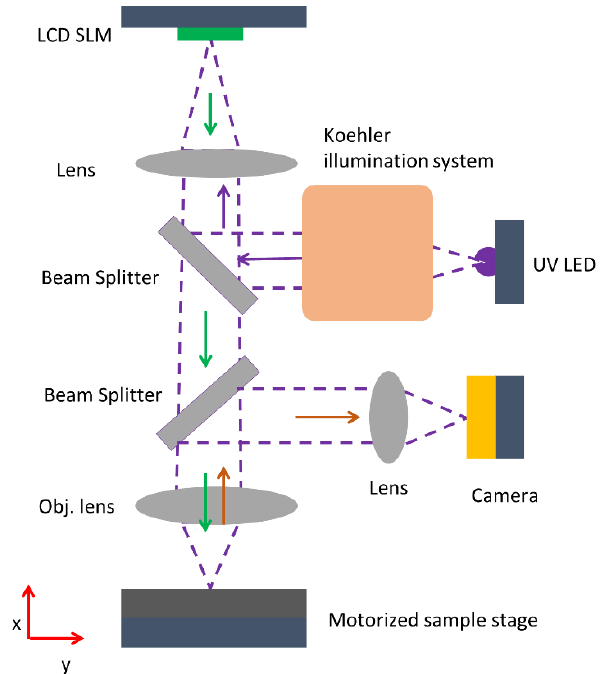
Figure 1. Scheme of the in-house maskless optical lithography setup used to fabricate the waveguide structures.